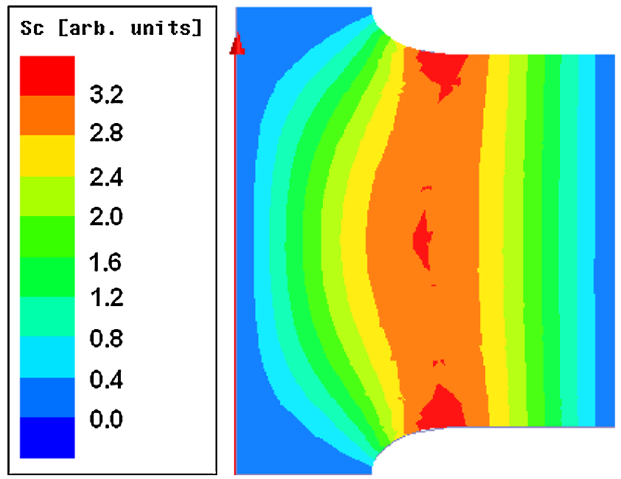
FIG. 14. (Color) Distribution of S number 15 from Table I is taken as an